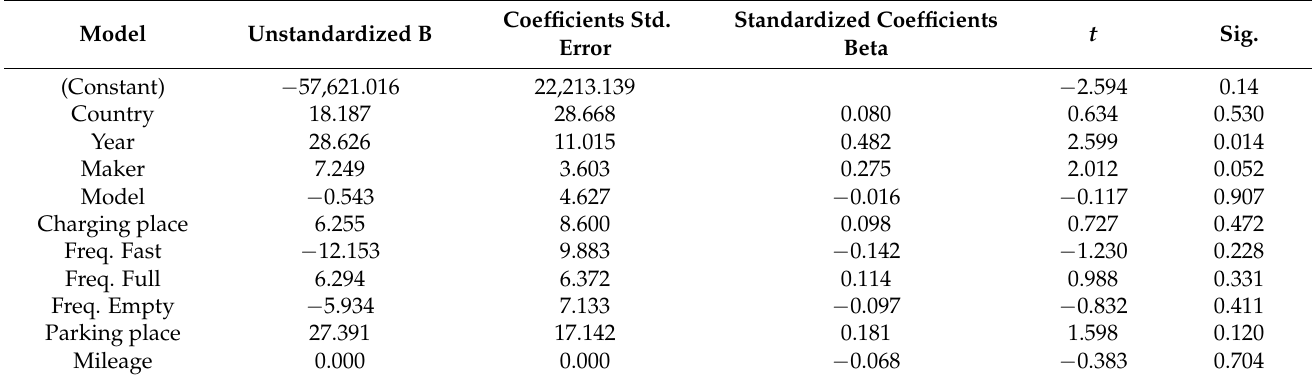
Table 5. SPSS coefficients table with all